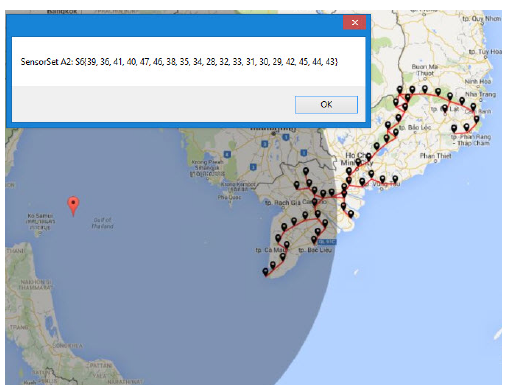
Figure 9. Determinethe sensorsets correspondingto each sub- satellite along the groundtrack of BEESAT-3 in orbit12794.